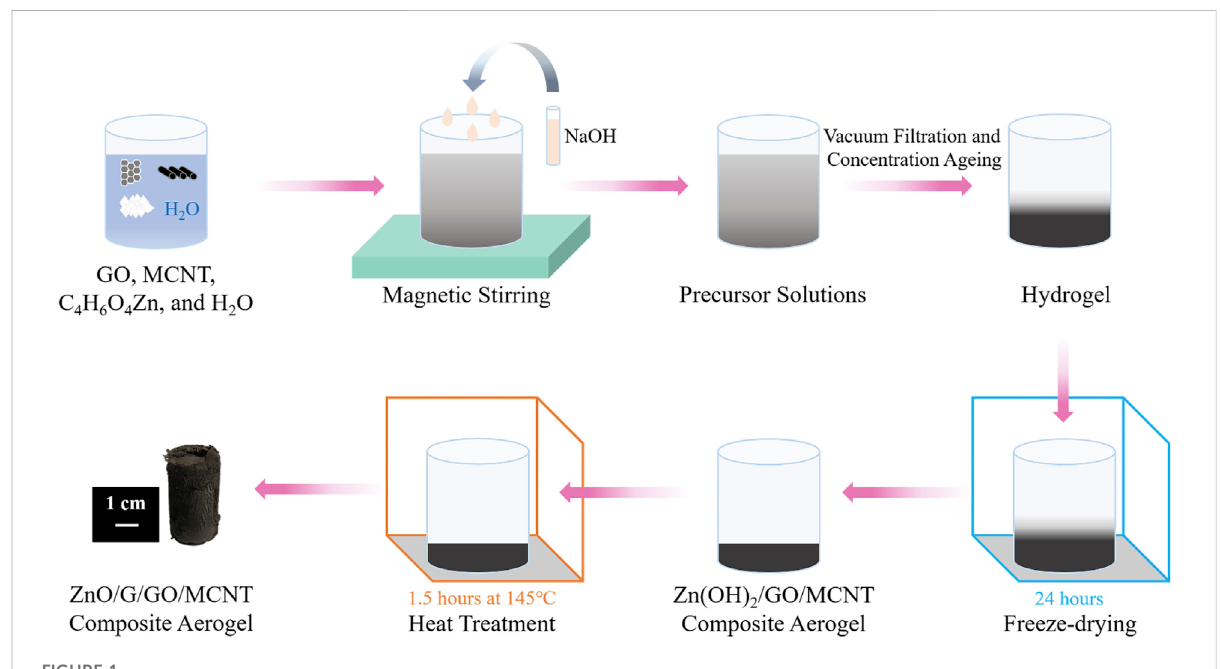
FIGURE 1 The preparation process of ZnO/G/GO/MCNT composite aerogel.